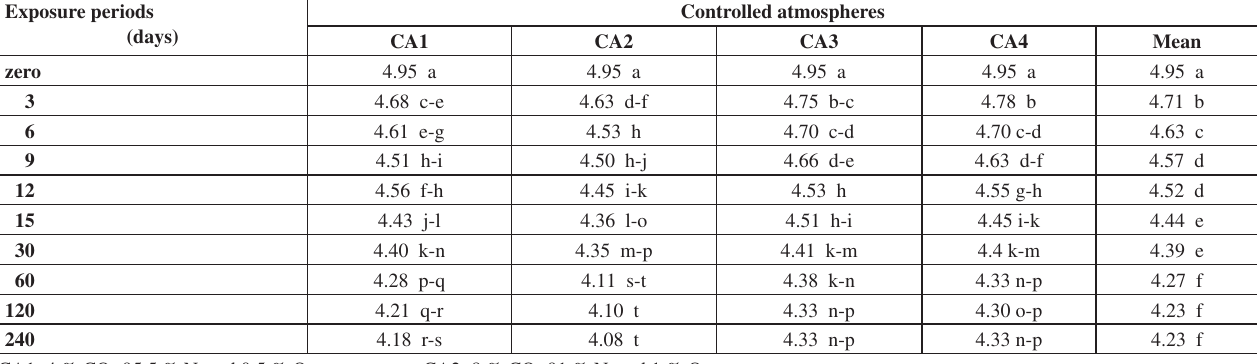
Table 2: Effect of exposure period and different controlled atmosphere on water content of onion seeds stored for 12 months Exposure periods